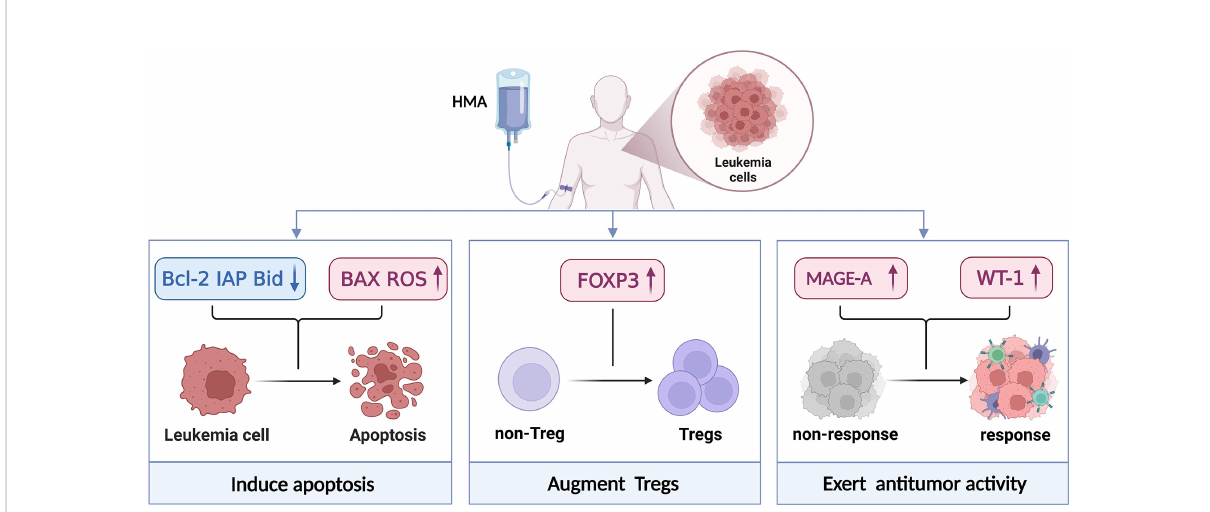
proteins, BAX activation and ROS upregulation which contributes to cell death. HMAs could mitigate GvHD by increasing the number and function (CD4 + CD25 - non-Tregs convert to CD4 + CD25 - FOXP3 + Tregs) of Tregs after allo-HSCT. And their suppressor function is dependent on